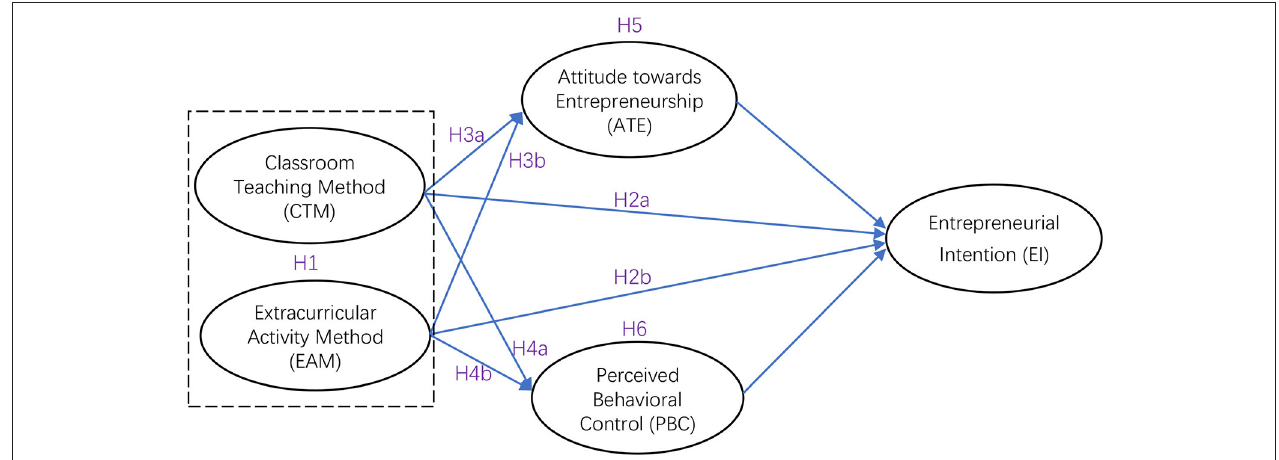
FIGURE 1 | Theoretical model of the study.